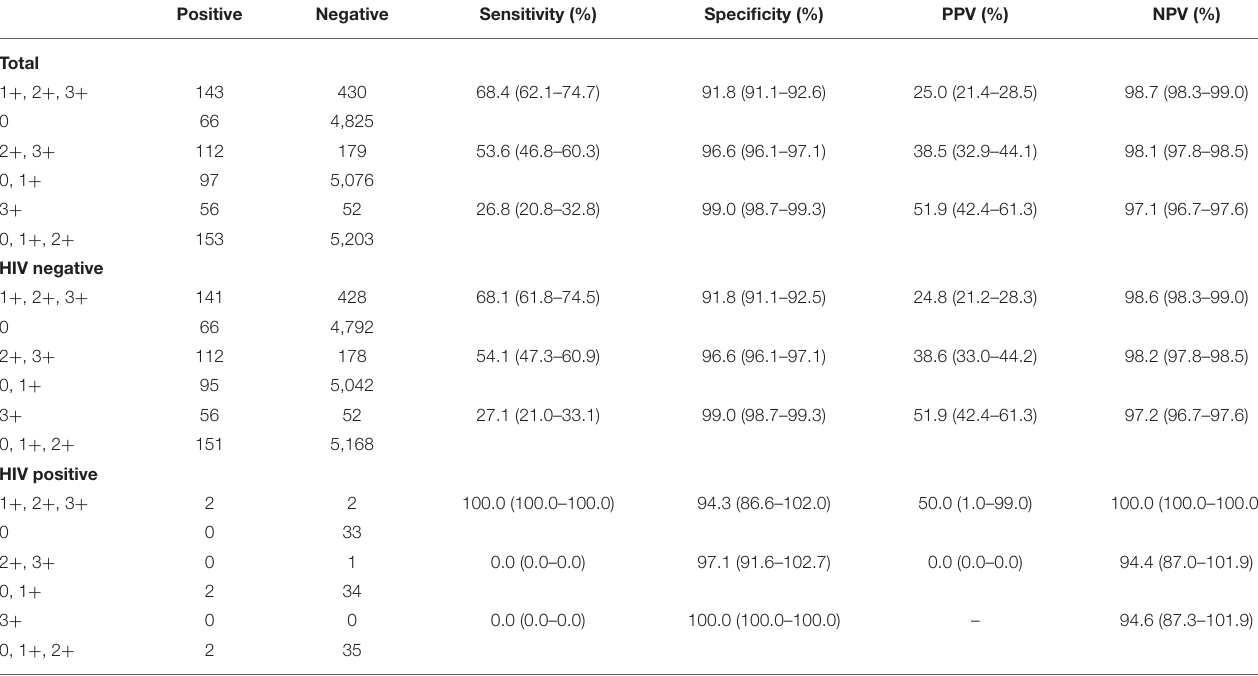
TABLE 4 | Diagnostic performance of LET to predict Gonorrhoeae infection. Positive